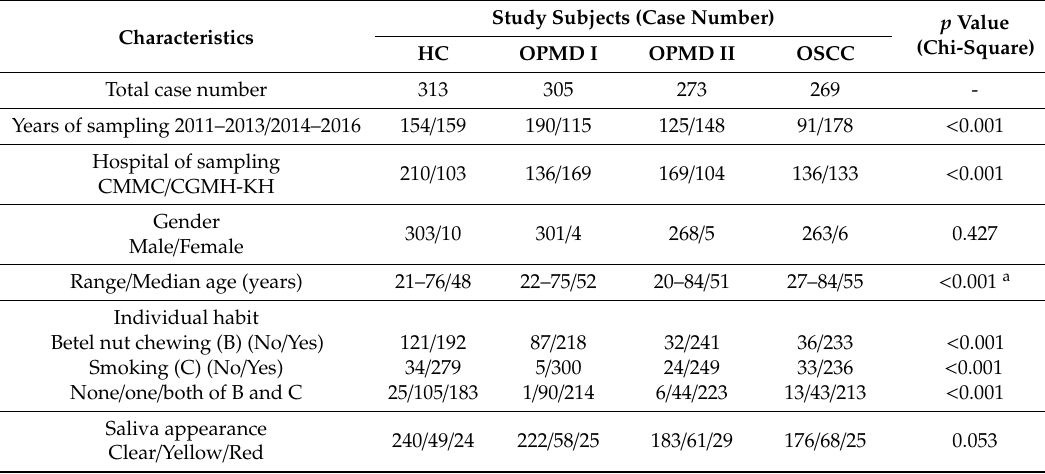
Table 1. Demographics of clinical cases in this